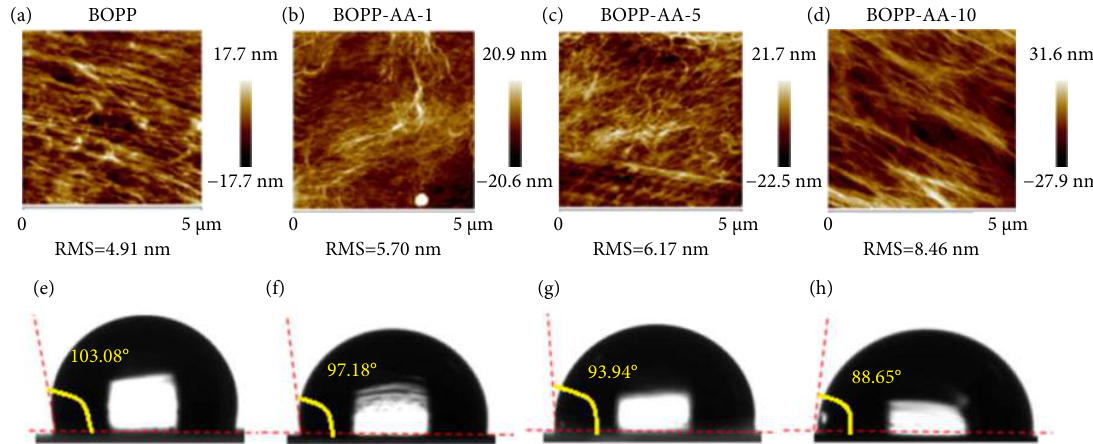
Fig. 2 Surface microstructure characterization using atomic force microscopy and water contact angles. (a, e) BOPP. (b, f) BOPP–AA-1. (c, g) BOPP–AA-5. (d, h)